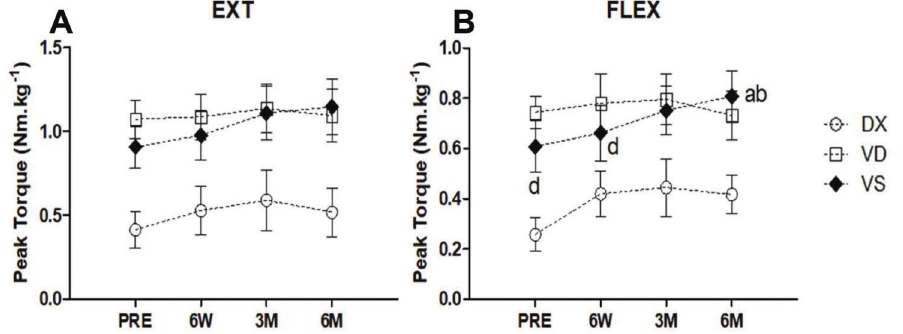
Figure 4 - Strength evaluation. A. Knee extensor peak torque. No significant differences regarding PT EXT over time ( p =0.07) were identified. Analysis between groups presented significant differences ( p =0.02). Pairwise differences were observed between DX and VD ( p =0.027) and between DX and VS ( p =0.043). B. Knee flexor peak torque. Regarding PT FLEX, significant main effects were observed both over time ( p =0.01) and between groups ( p =0.02). A pairwise significant difference was observed for DX and VD ( p =0.034), but not for DX and VS ( p =0.067). Further separate analysis revealed significant differences in both PT EXT ( p =0.03) and PT FLEX ( p =0.03) only in the VS group. Symbols represent mean values, dashed and straight lines represent standard deviations. 6 W: six weeks, 3 M: